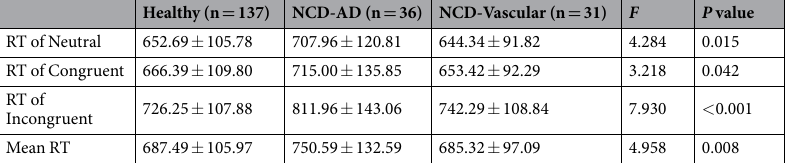
Table 2. Comparisons of mean RT between healthy and NCD